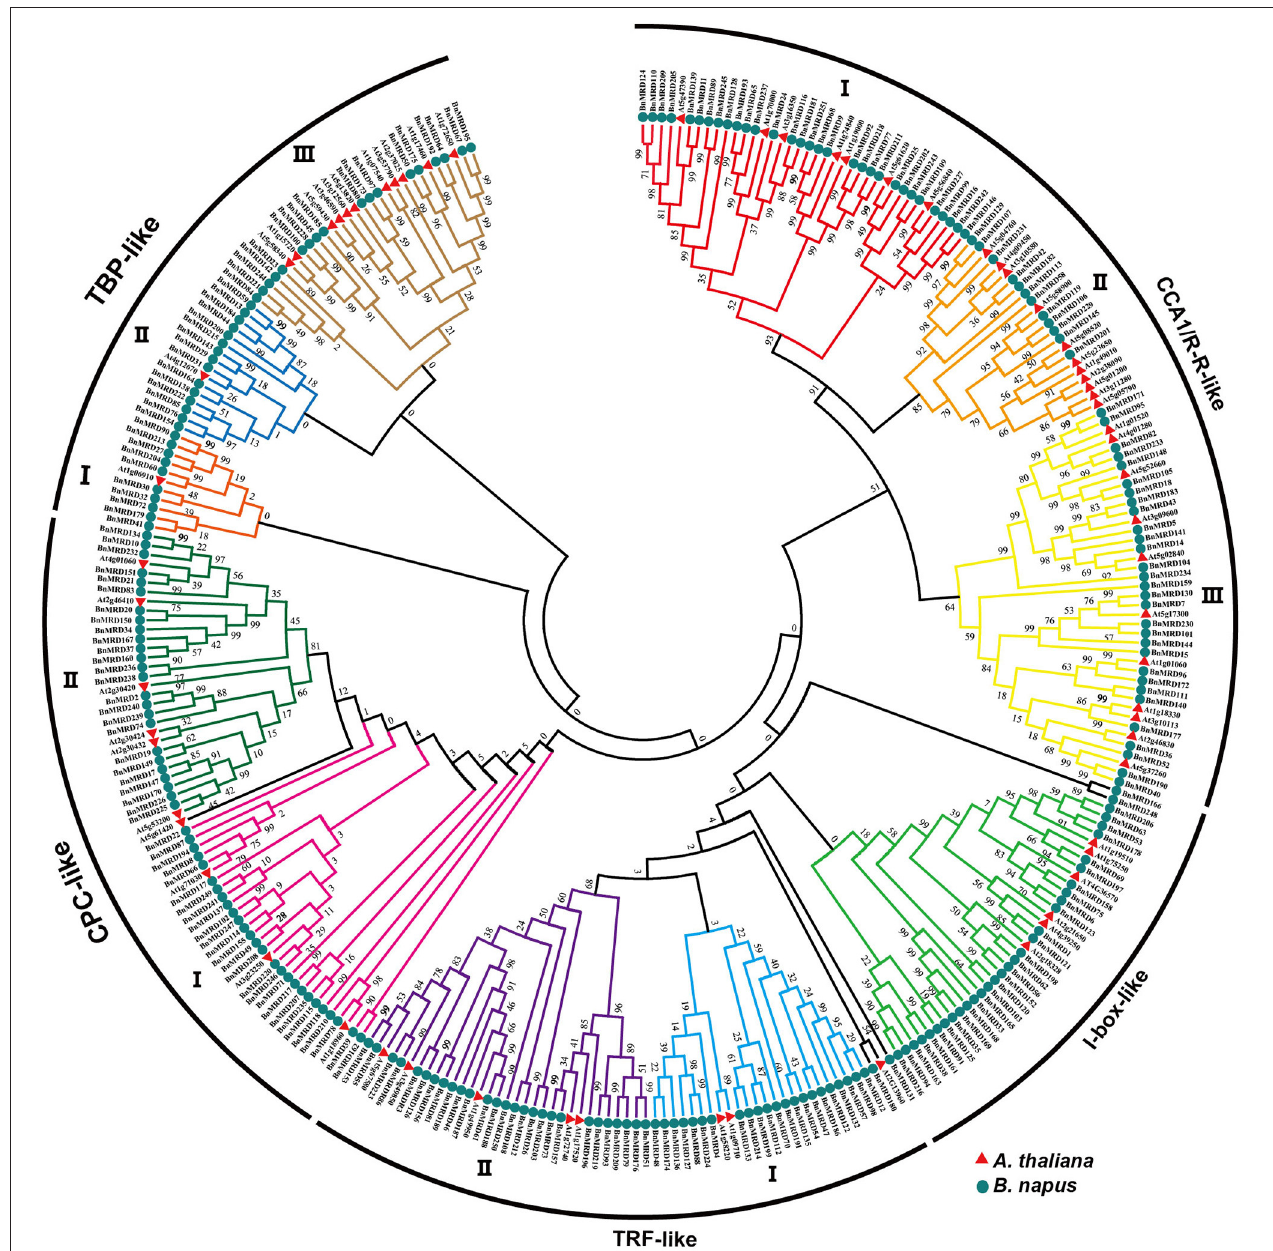
FIGURE 1 | Phylogenetic analysis of MYB-related proteins using MEGA 7.0 with the neighbor-joining (NJ) method. Numbers at the nodes represent the reliability percentage of the bootstrap values based on 1,000 replications. Red triangles and green circles represent the MYB-related proteins in Arabidopsis thaliana ( A. thaliana ) and Brassica napus ( B. napus ),